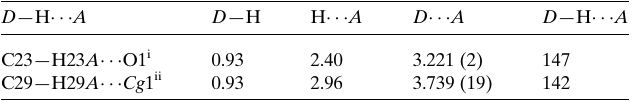
Table 2 Hydrogen-bond geometry (A˚ , (cid:3) ) for (II). Cg 1 is the centroid of the C18–C23 ring.